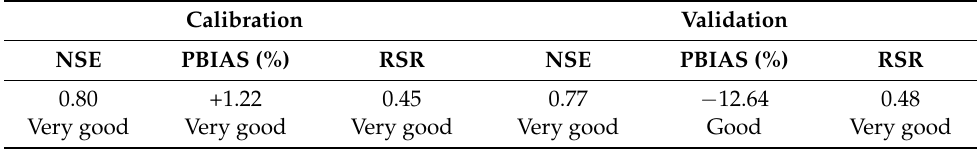
Table 4. Calibration and validation period performance.